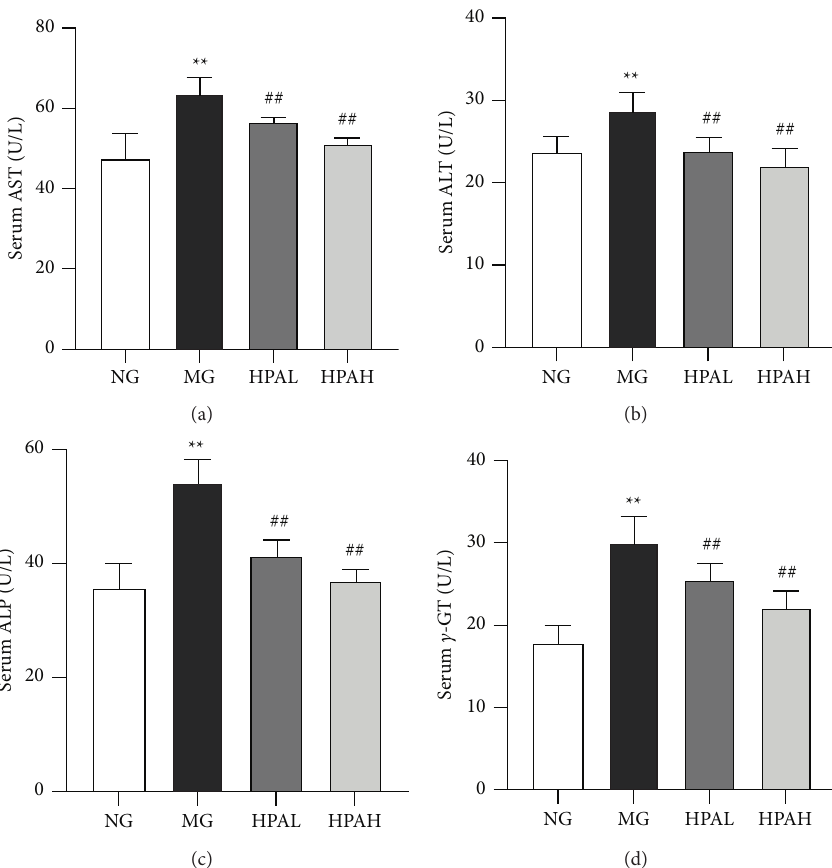
Figure 2: Effect of HPA on the hepatic function in ALD mice. (a) Serum AST; (b) serum ALT; (c) serum ALP; (d) serum c -GT. Data were expressed as mean ± SD ( n � 12). ∗∗ p < 0 . 01, versus NG; # p < 0 . 05 and ## p < 0 . 01, versus